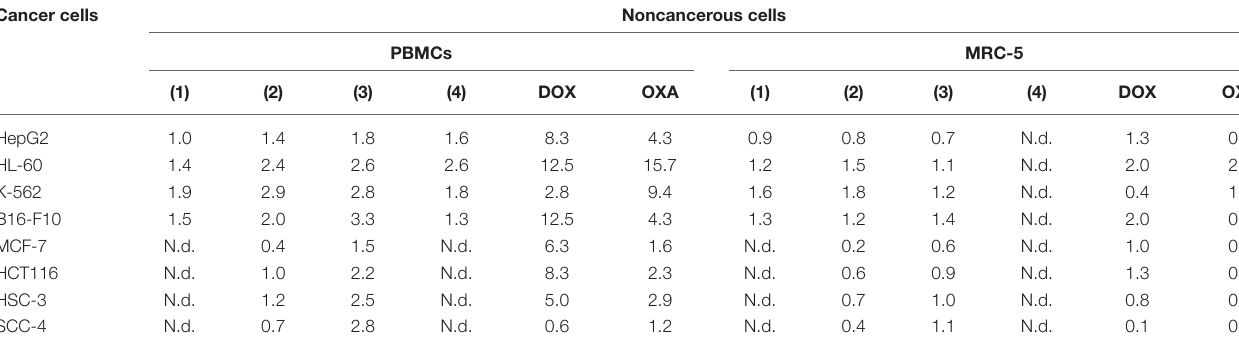
TABLE 2 | Selectivity index of ruthenium complexes containing heterocyclic thioamidates. Cancer cells